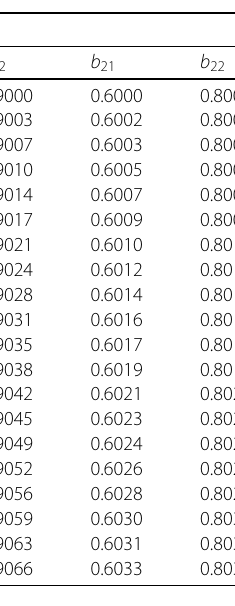
Table 1 Numerical results of a ij and b ij , where i = 1,2 and j = 1,2, in Example